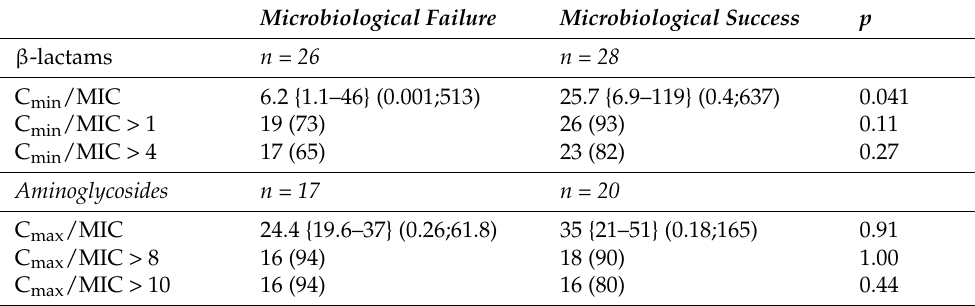
Table 6. Comparison of pharmacokinetic/pharmacodynamic parameters according to microbiological outcome on day